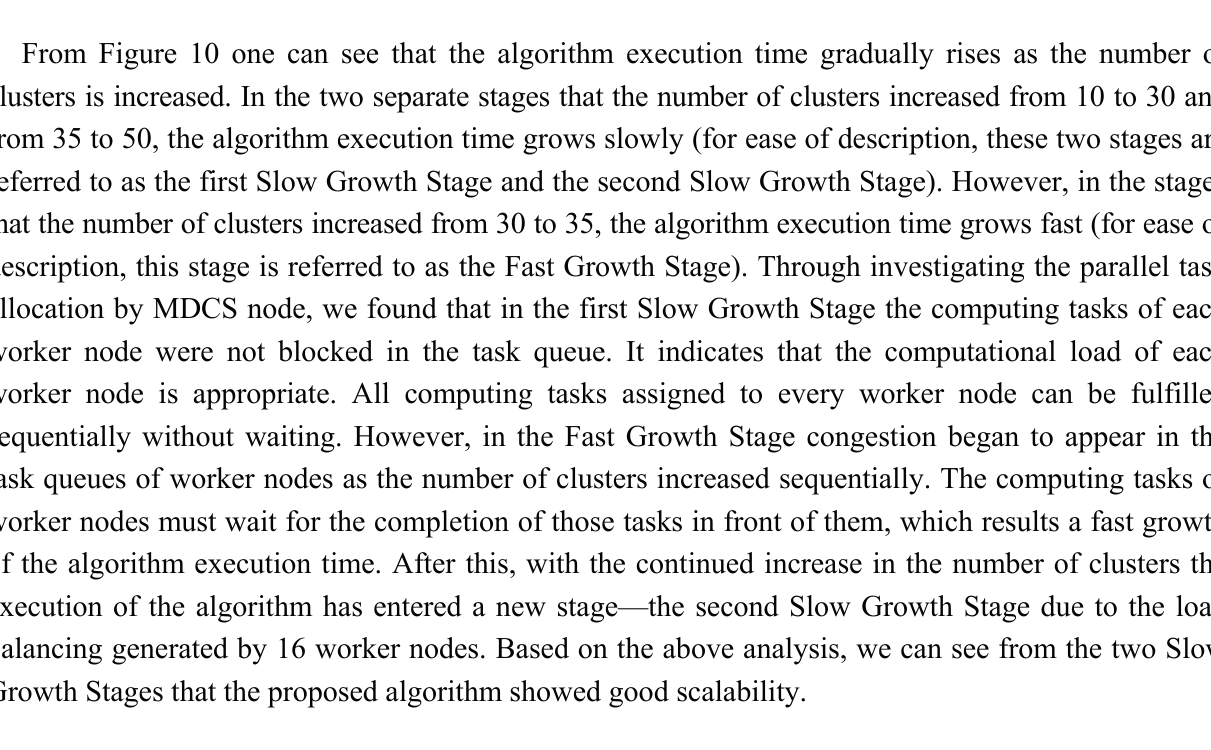
Figure 10. Algorithm execution time along with the number of clusters growing from 10 to